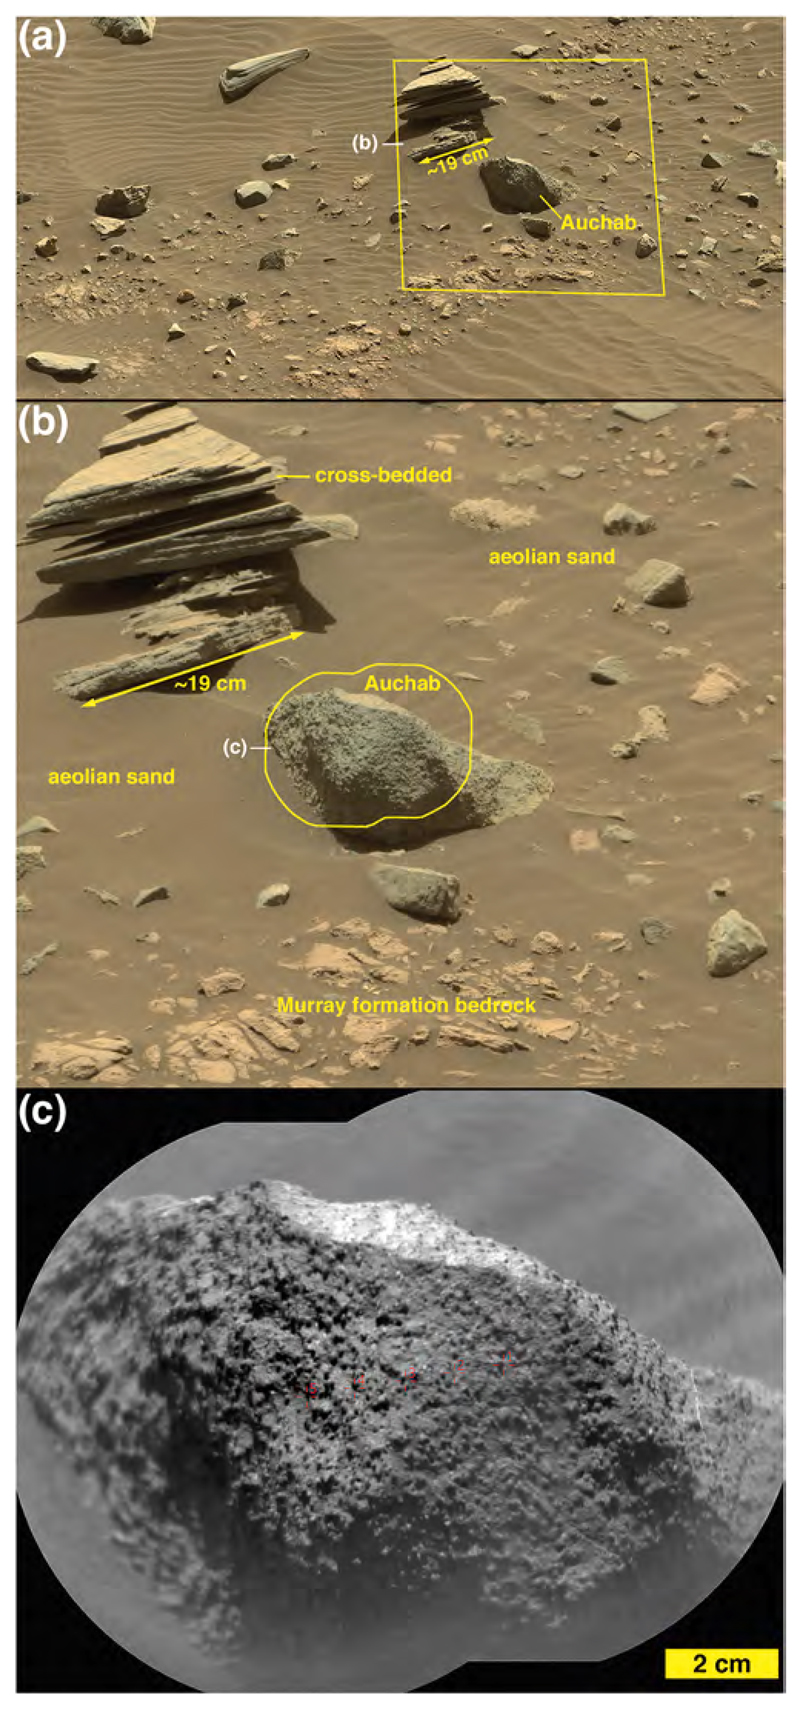
(a) Local context for ChemCam target Auchab; yellow outline indicates location of panel (b): closer view of knobby gray target Auchab; yellow outline indicates ChemCam RMI coverage in (c). Note the nearby angular, cross-bedded sandstone clast. Both stones are surrounded by windblown sand and overlie reddish Murray-formation bedrock. (c) ChemCam RMI mosaic showing the nodular texture of Auchab. (For interpretation of the references to color in this figure, the reader is referred to the web version of this article.)